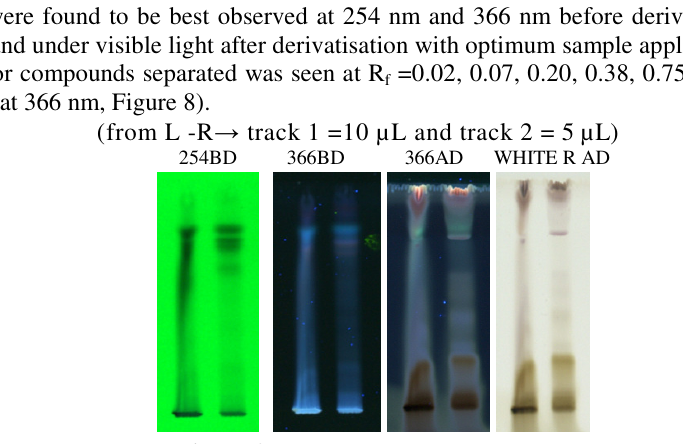
Figure 8 . (Plate no 8) HPTLC of